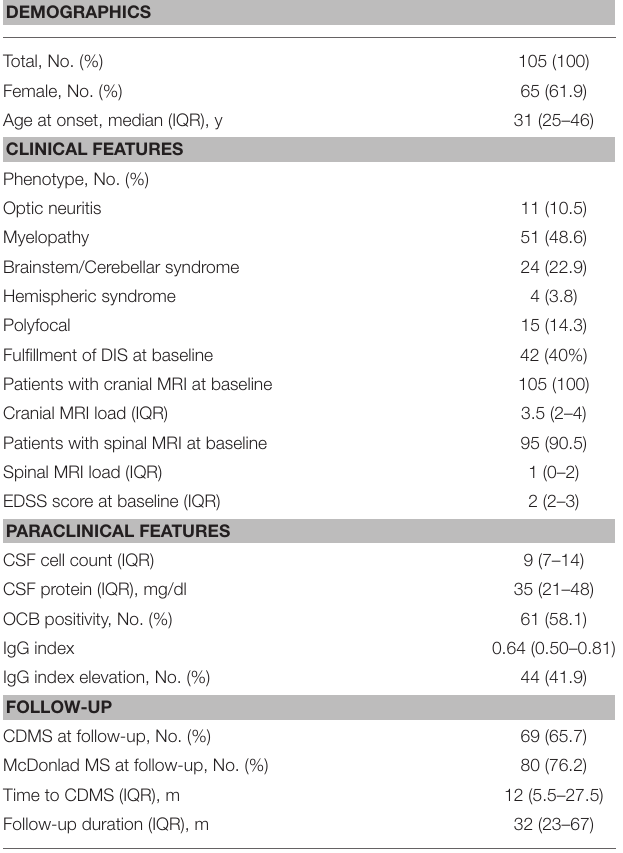
TABLE 1 | General characteristics.